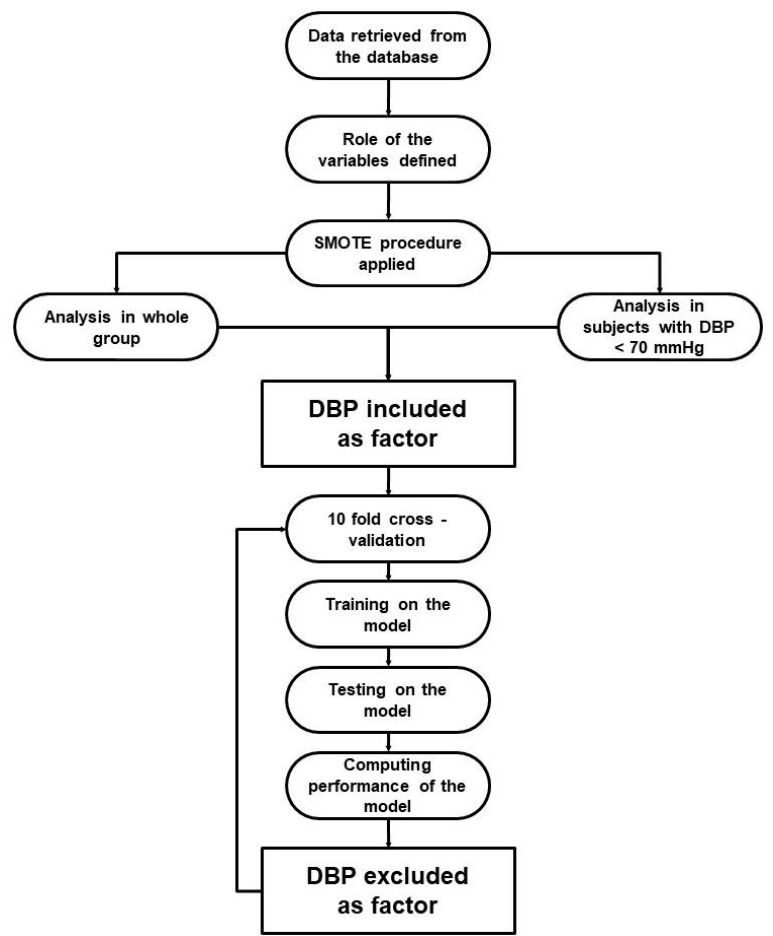
Figure 1. Flowchart presenting ML experiment phases. DBP — diastolic blood pressure, SMOTE — synthetic minority oversampling technique.